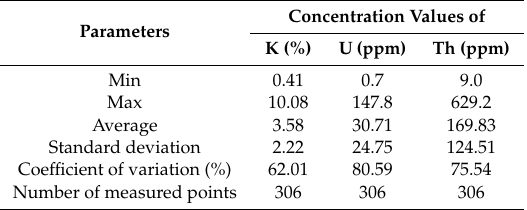
Table 4. Statistic of characterization of gamma spectra in the soil.